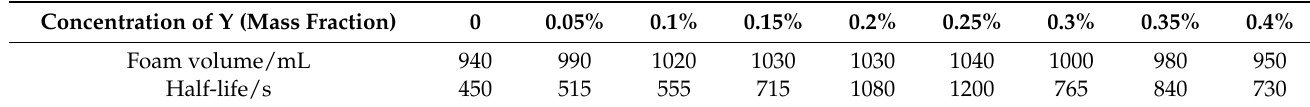
Table 4. Foam amount and half-life of Y at different